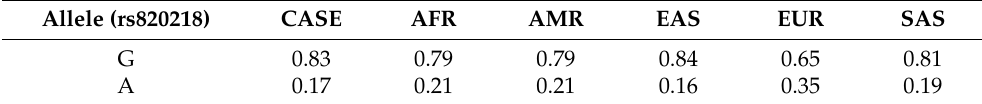
Table 4. Comparison of allelic frequencies between the case population and each of the 1000 Genomes Table 3. Distributions of allelic frequencies of rs820218 of the SAP30BP gene in the populations. Allele